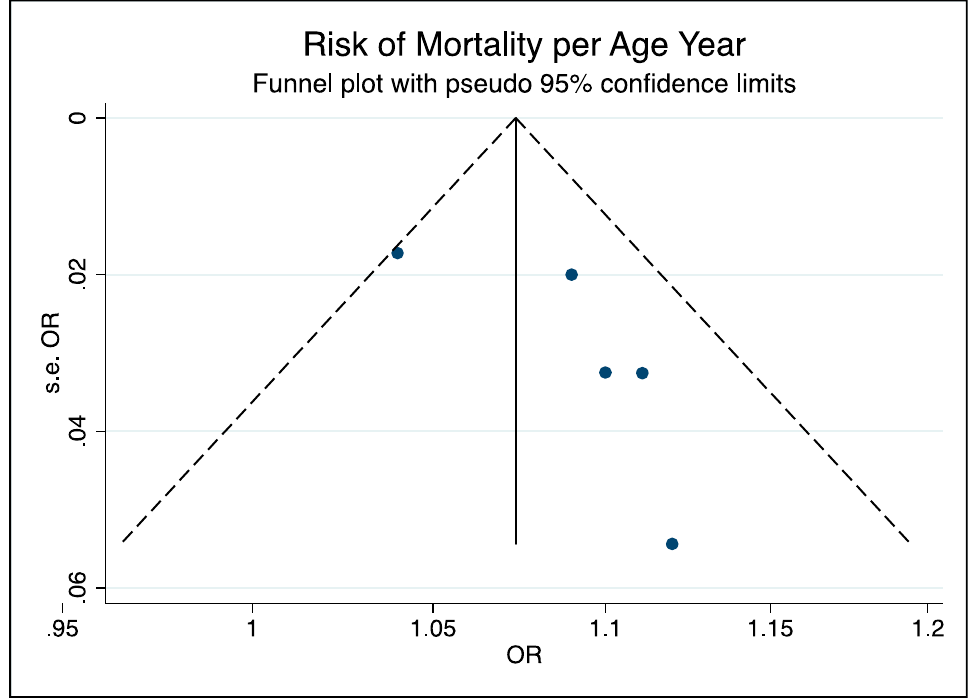
Figure 5. Funnel plot of mortality per age year.